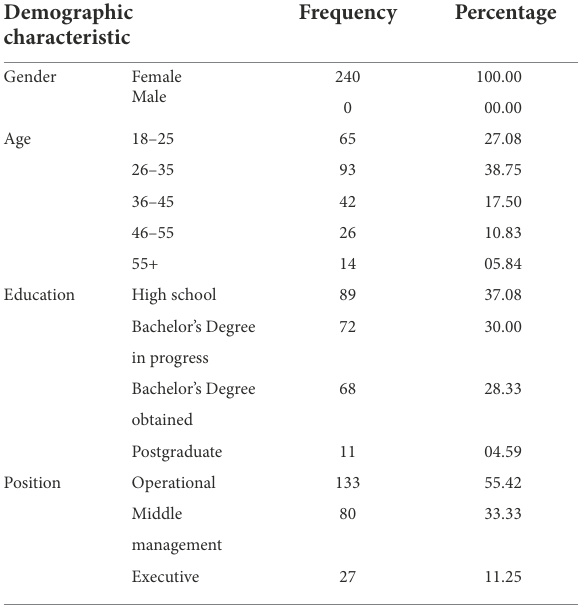
TABLE 1 Demographic characteristics of the participants ( n = 240). Demographic